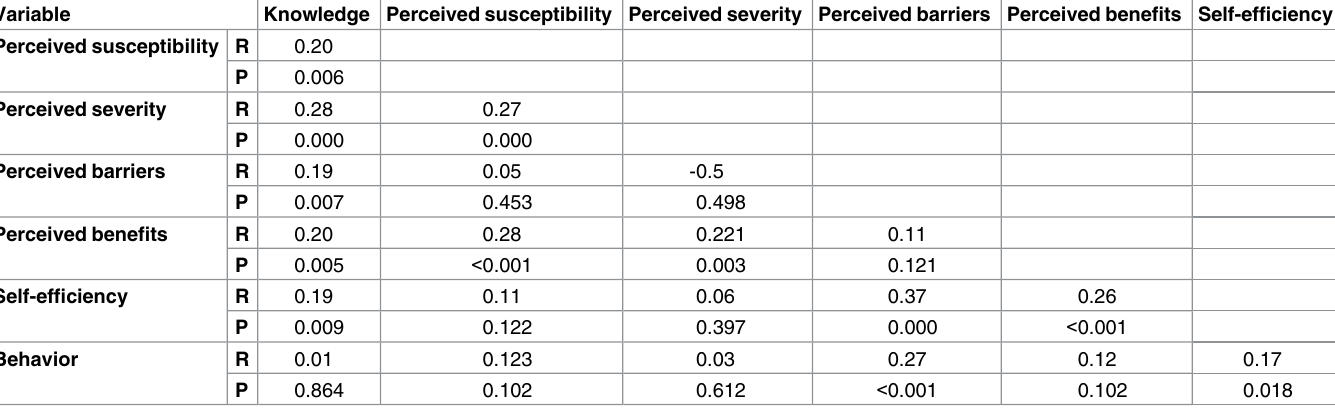
Table 4. Pearson’s correlation coefficients (r) between knowledge, constructs of the Health Belief Model, and behaviors to prevent pediculosis.